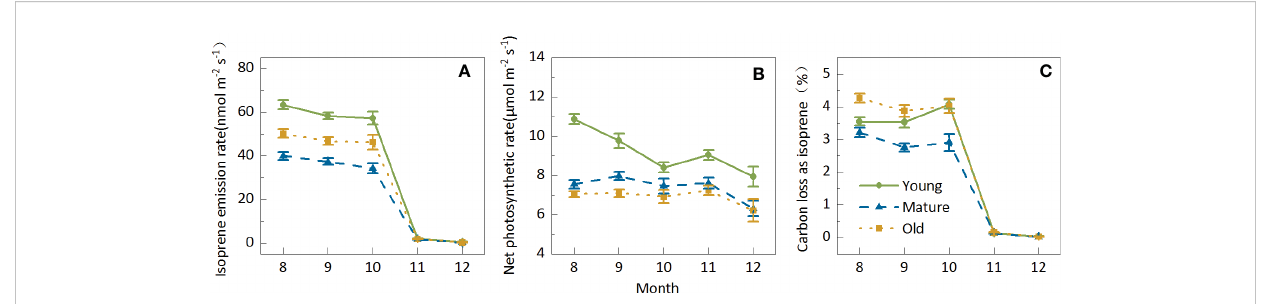
FIGURE 3 Seasonal variations in isoprene emission (A) net photosynthetic rate (B) and carbon loss as isoprene (C) of Moso bamboo and photosynthesis of Moso bamboo. Data are mean ± SE of 10 – 43 leaves from 267 samples for isoprene tests. During the measurements, leaf temperature was set to